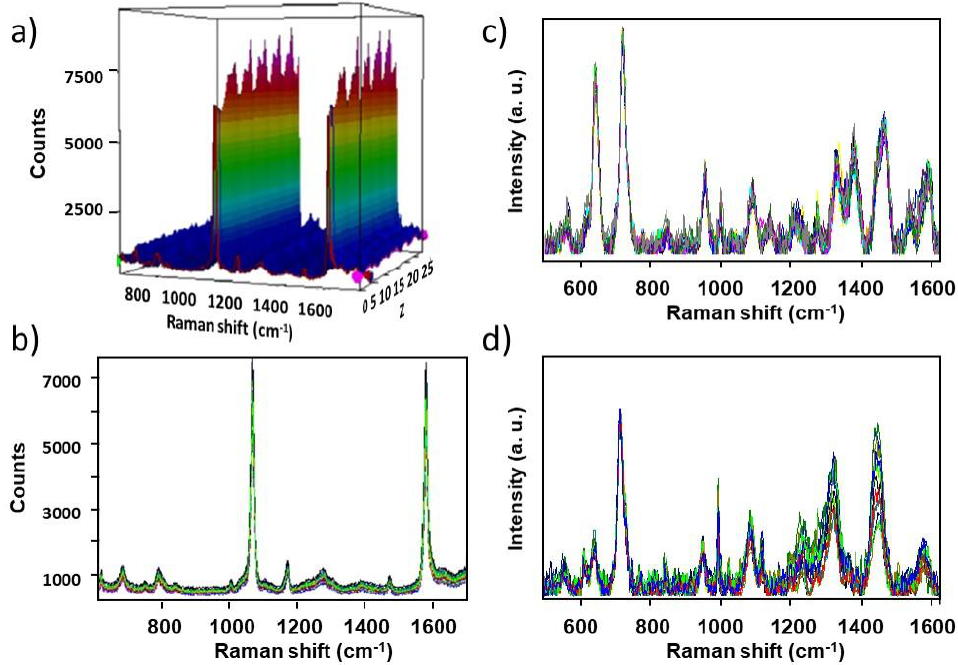
Figure 9. The representative SERS spectra of ( a , b ) p -MBA of concentration of 10 -6 M, ( c ) B. subtilis , and ( d ) E. coli recorded from 30 different spots on the SERS surface (Type I) using mapping mode. The spectra were collected over a distance of 1 mm with 10 µm steps (30 spectra are shown). Each point in the map was recorded using 5 mW of 785 nm excitation.